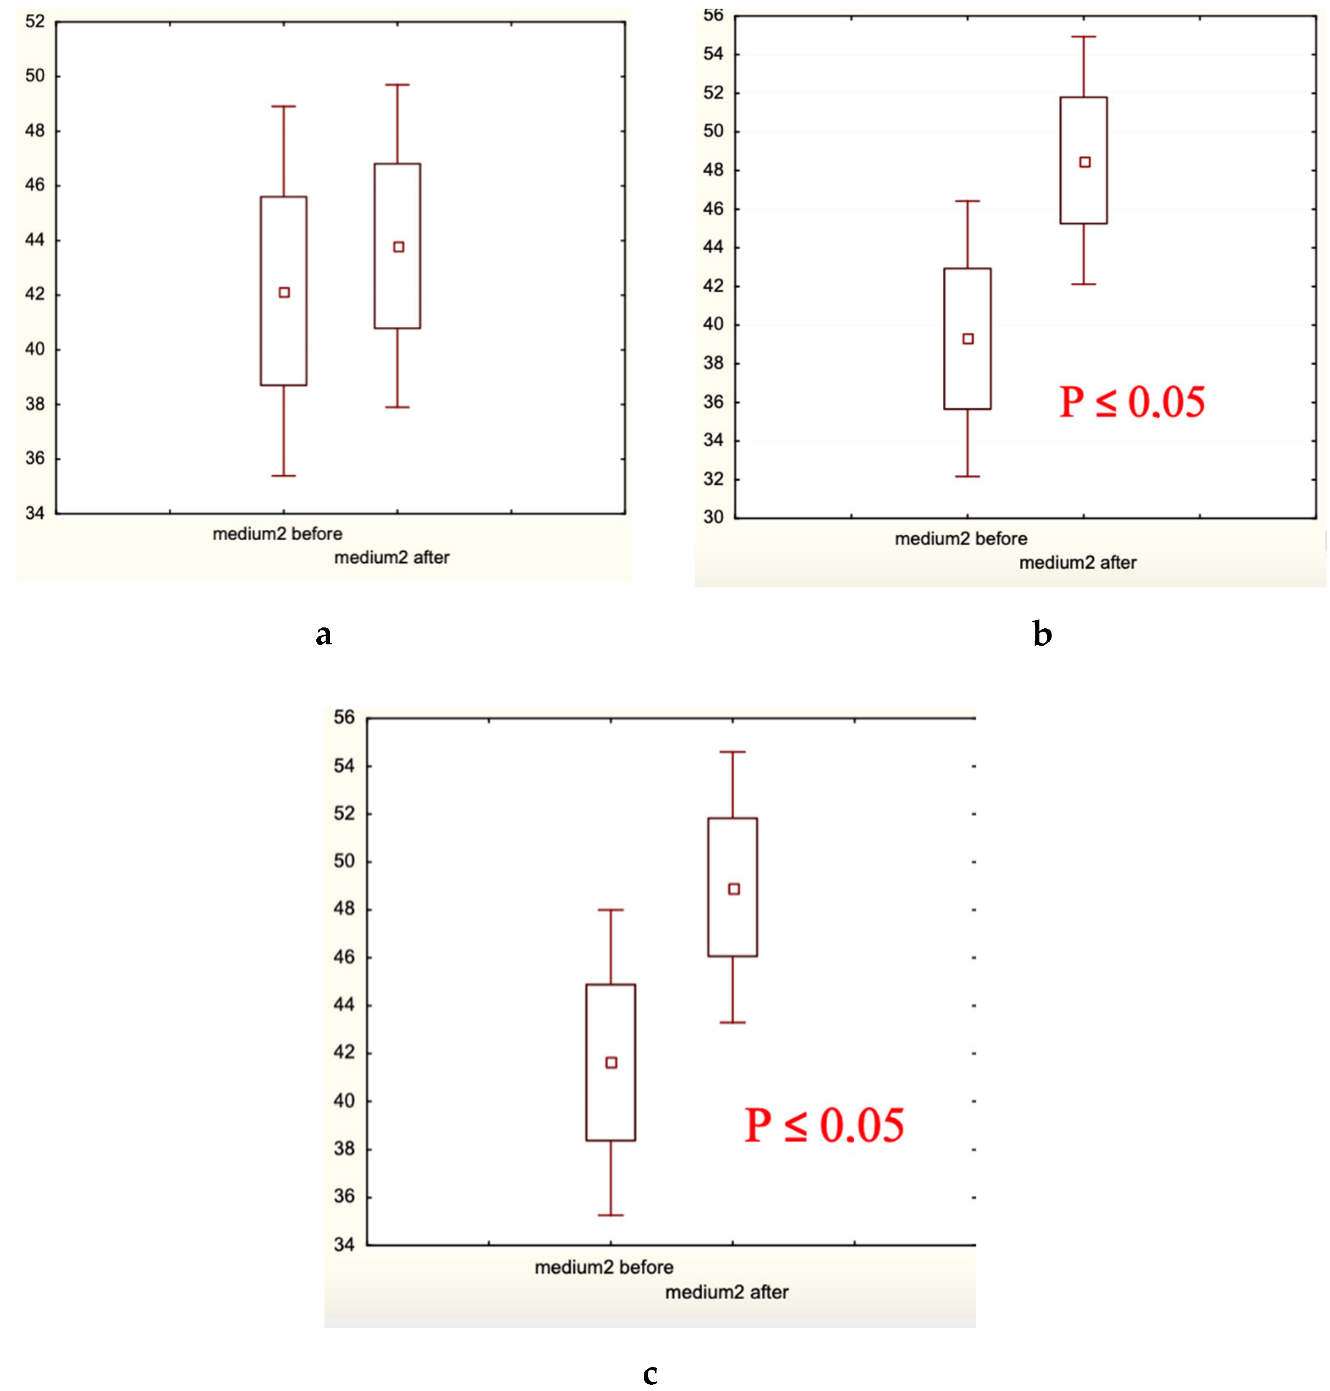
Figure 8. Medium hair presence (%) before and after the trial: ( a ) Experimental Group 1; ( b ) Placebo Control Group 2; ( c ) Caffeine Control Group 3. Small boxes—median values; large boxes—median values ± standard error of median (SEM); whiskers—median values ± 1.96 SEM. p < 0.05.